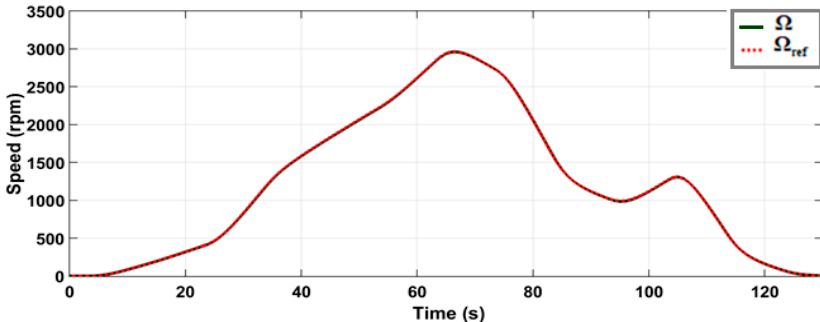
Table 3. FOPI controller parameters summary.